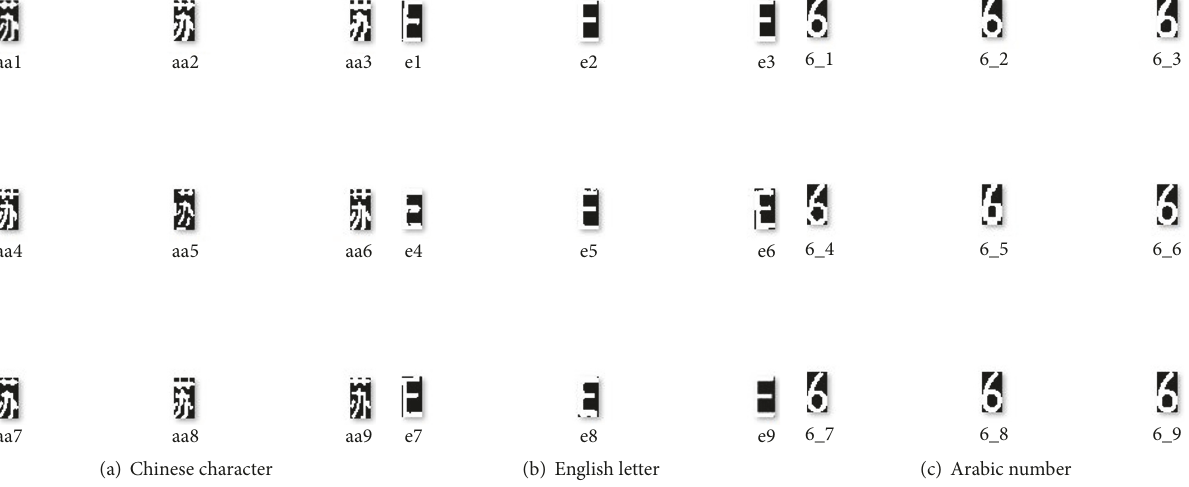
Figure 13: The license plate training samples.